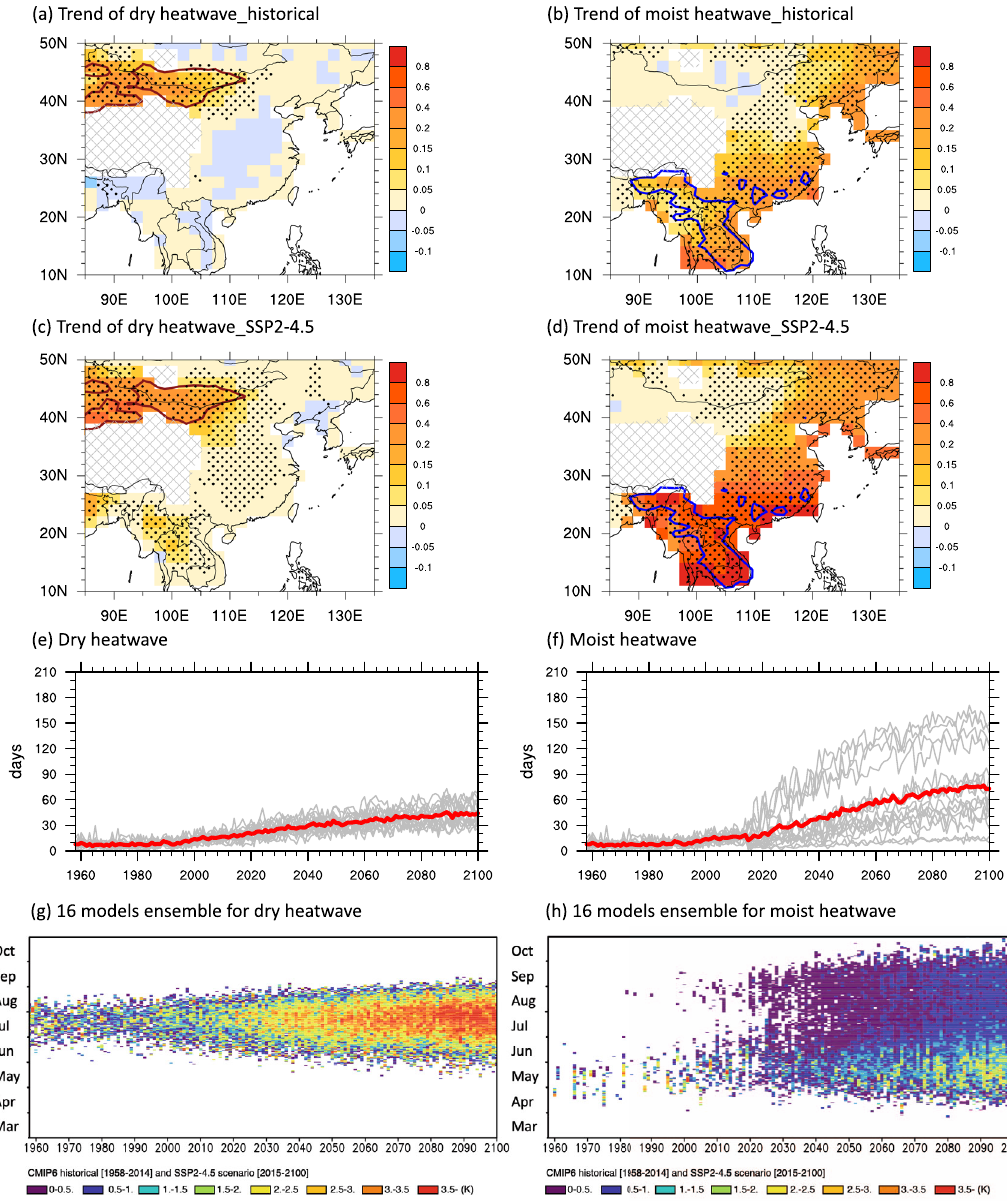
Fig. 6 Heatwaves over dry/moist heatwave regions using JRA-55, CMIP6 historical, and SSP2-4.5 scenario. a Trend of dry heatwave days per year and b moist heatwaves during the period from 1958 to 2014 based on the multi-model mean. Heatwaves were de fi ned as days on which the 90th percentile of daily mean temperature was reached for at least 3-days, based on the historical run simulation of each model from 1958 to 2014. The dots indicate the 90% con fi dence level using the P -value. The red and blue contours in a and b represent areas with trend above 0.15 days year − 1 based on JRA-55 data during 1958 – 2019 for dry and moist heatwaves, respectively. The hatched areas indicate above 2000 m in geopotential height. c and d are the same as a and b but, respectively, for SSP2 – 4.5. Time series of heatwave durations over e dry and f moist heatwave regions (brown contour in ( a ) and blue contour in ( b )). The gray lines denote the results of each model and the red lines indicate the result of the multi-model ensemble mean. The timing of ( g ) dry and ( h ) moist heatwaves from March to October during difference between the daily mean temperature and the 90th temperature percentile. For the future projection, we used the 90th temperature percentiles based on the period from 1958 to 2014 from the historical run simulation of each